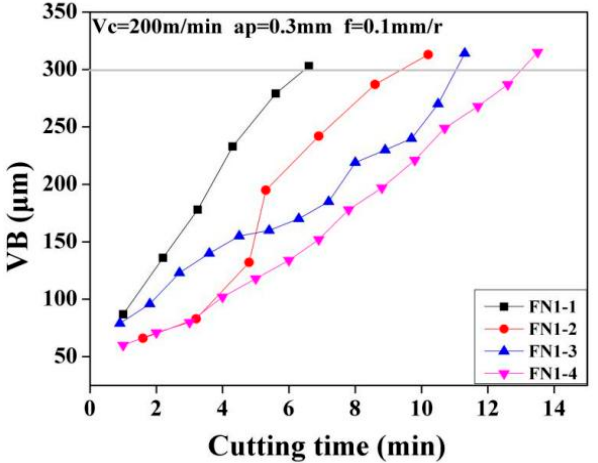
Figure 12. The flank wear VB vs. cutting time for WC-Ni-Zr.